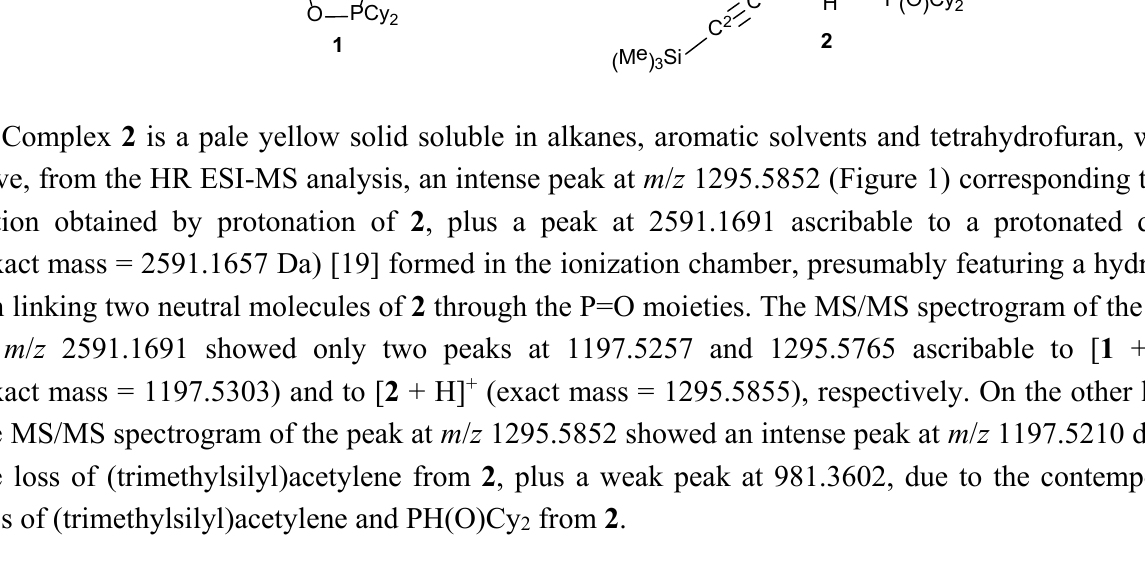
Figure 1. HR ESI-MS spectrograms of 2 showing the peaks due to [ 2 + H] + ( A ) and [2· 2 + H] + ( B ). The errors between simulated and observed isotopic patterns are 0.7 ppm for [ 2 + H] + and − 1.0 ppm for [2· 2 + H] +